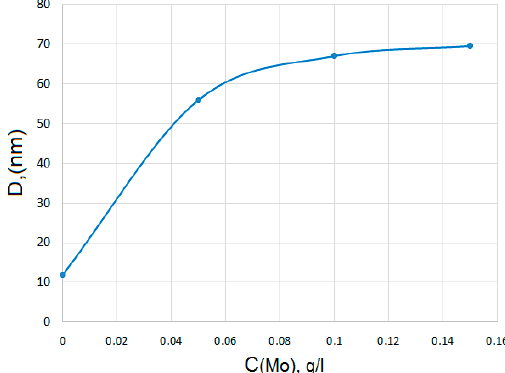
Figure 6. Dependence of the thickness of oxide-zirconium coatings on the concentration of Mo (VI) in the deposition solution.